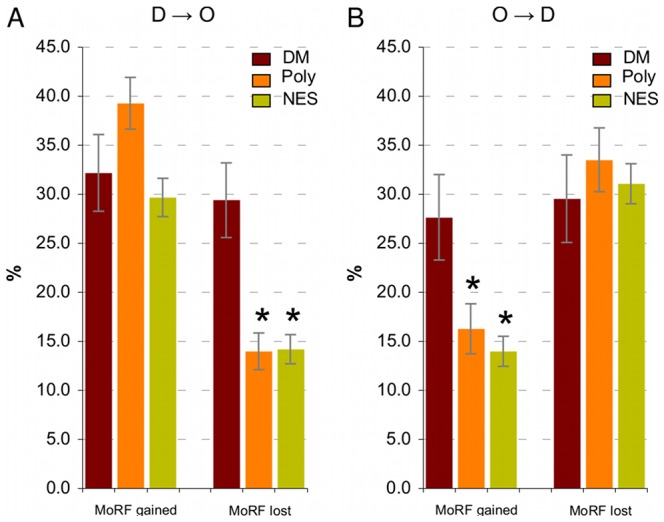
Disease D→O transition mutations lead to the loss of predicted α-MoRFs (panel A), while O→D transition mutations lead to the gain of predicted α-MoRFs (Panel B) significantly more frequently than control mutations.Y-axes show fractions of all D→O and O→D mutations that cause loss or gain of the predicted α-MoRFs, and error bars correspond to one standard deviation.